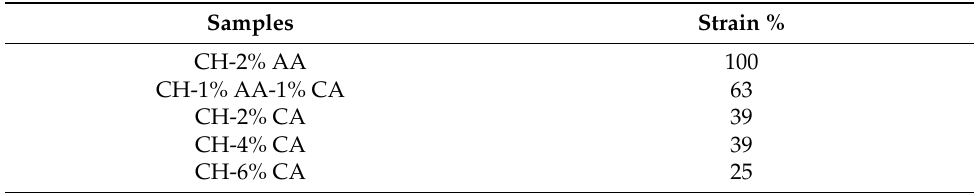
Figure 3. Oscillatory amplitude sweeps of chitosan solutions prepared using acetic acid (2% v / v ) and citric acid (2, 4 and 6% w / v ). Table 2. Limit strain of the LVE % of chitosan solution prepared using acetic acid (2% v / v ) and citric acid (2, 4 and 6% w / v